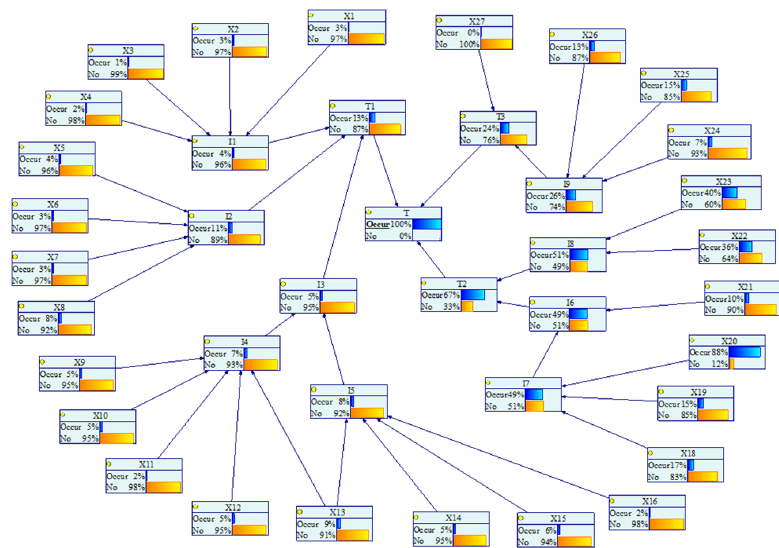
Figure 11. The posterior probability of each node in the BN of the coal gasifier. By comparing the prior and the posterior probability regarding each root node, as shown in Figure 12, the root nodes with large changes in occurrence probability can be obtained as X 22 (Anti-corrosion layer damaged), X 23 (Insulation layer damaged) and X 25 (Improper operation), indicating that these three root events have a large contribution to the failure probability of the gasifier. The acquisition of the prior and the posterior prob- ability shows the forward-inference (prediction) ability and backward-inference (diagno- sis) ability of the BN, respectively, which completely reflects the superiority of the BN’s bidirectional-inference ability. Meanwhile, this ability can be used to provide preliminary judgments and lay the foundation for subsequent analysis and determination of key nodes. Figure 12. Prior and posterior probabilities of root nodes of the BN model. 4.5.3. SA and CIA